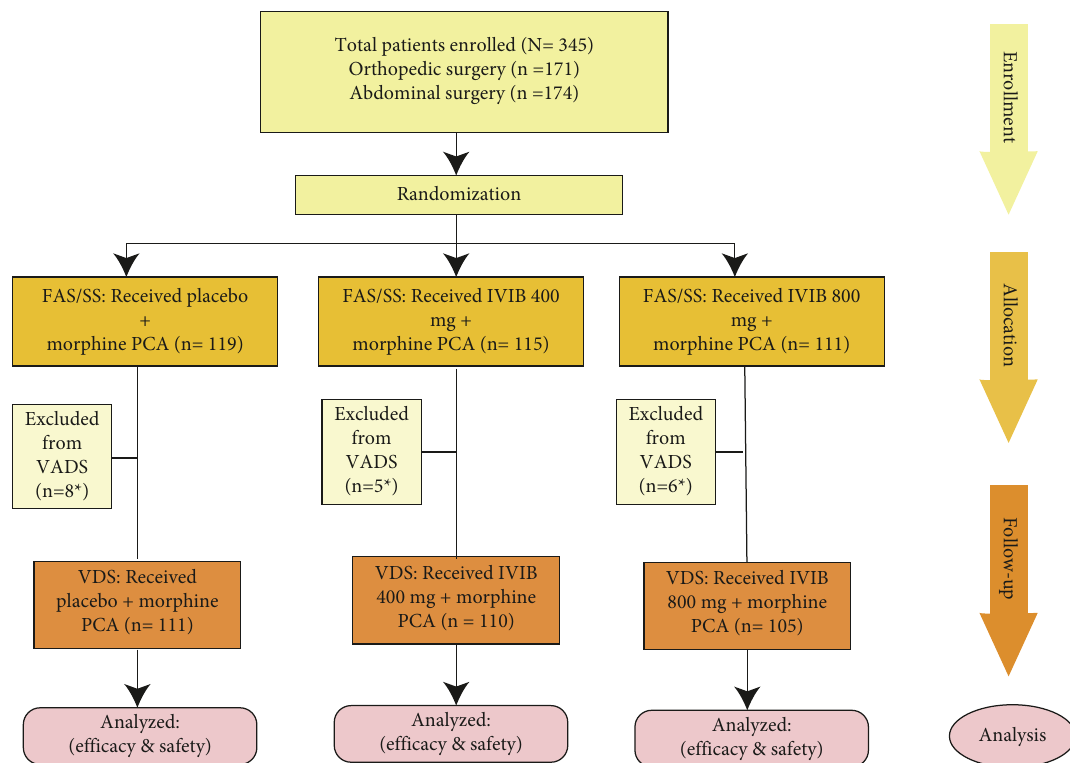
Figure 5: Distribution of surgery patients randomized to receive IVIB or placebo for postoperative pain. PCA, patient-controlled analgesia. FAS, full analysis set including all patients who were randomized and received at least a partial dose of IV ibuprofen or placebo; VAD, valid data set including all patients who receive at least 4 doses of IV ibuprofen or placebo as required by the study protocol; SS, safety set, including all patients who received at least a dose of IV ibuprofen or placebo and safety assessment after randomization. ∗ Reasons for exclusion from the efcacy population included adverse events, noncompliance, lack of efcacy, and withdrawn